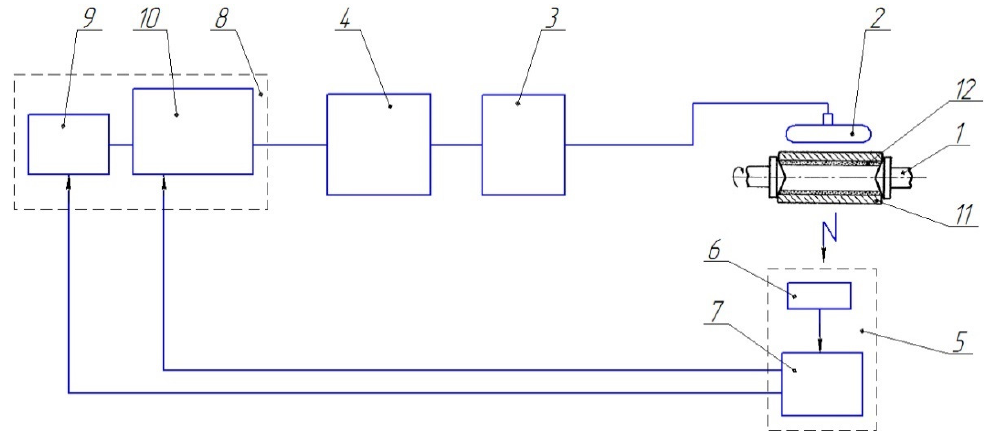
Figure 1. Scheme of induction surfacing of samples: 1—clamping centers; 2—a frame